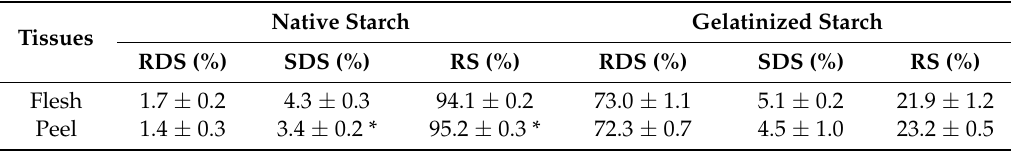
Table 4. Digestion properties of starches.